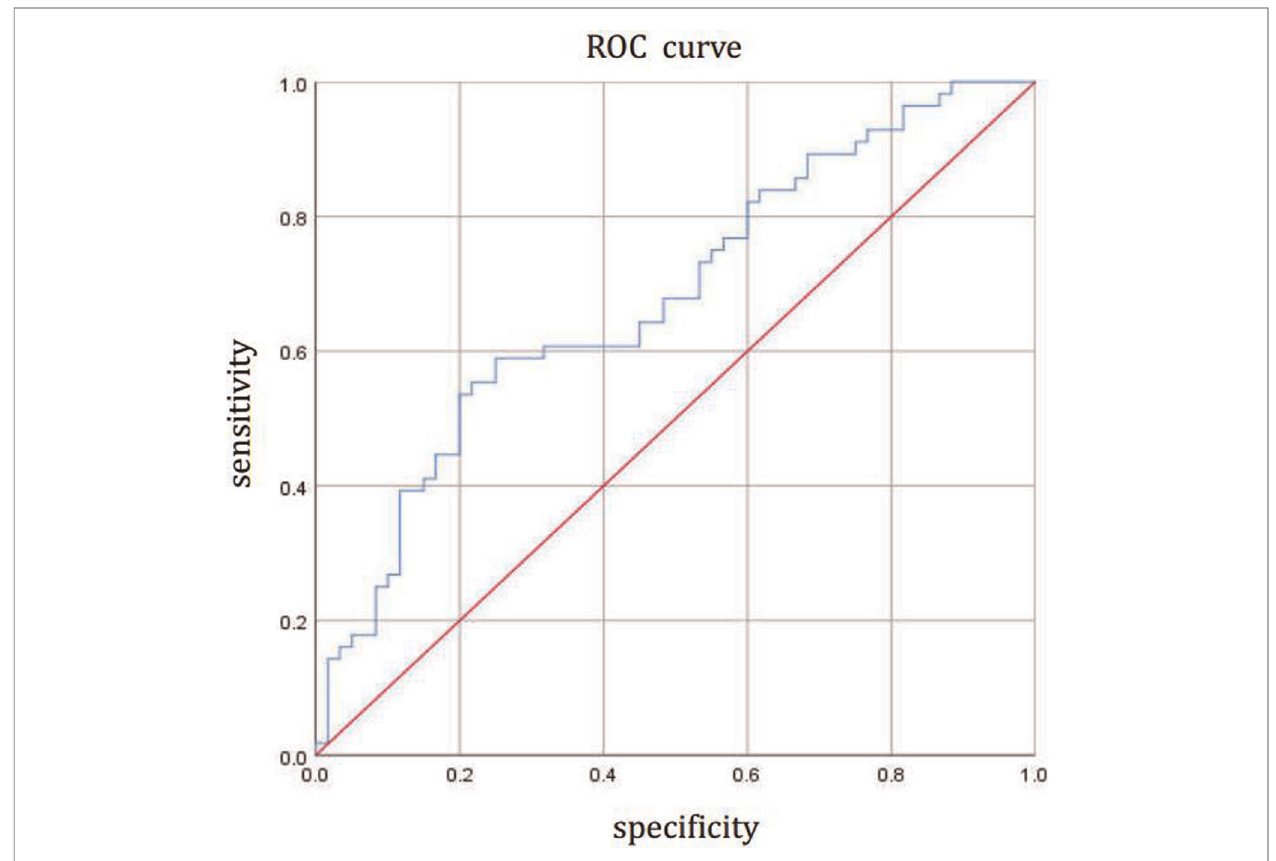
FIGURE 1 | ROC curve of serum β 2-GPI/oxLDL in the diagnosis of